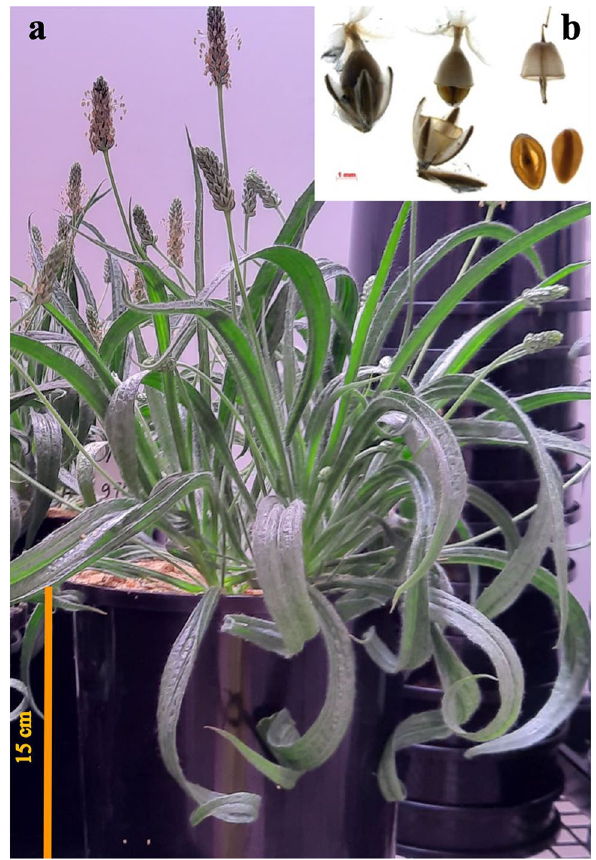
Figure 1. Plantago ovata . ( a ) A two-and-a-half-month-old plant. ( b ) Capsules containing two seeds each are fully ripened and shatter easily at around 25 days post anthesis